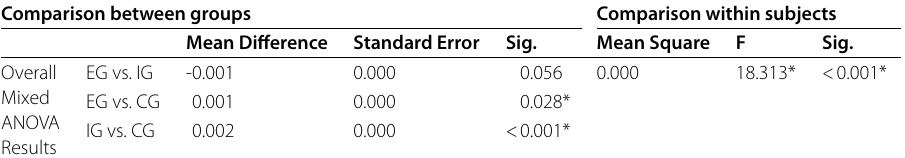
Table 8 Mixed ANOVA results for questions (normalized values) Comparison between